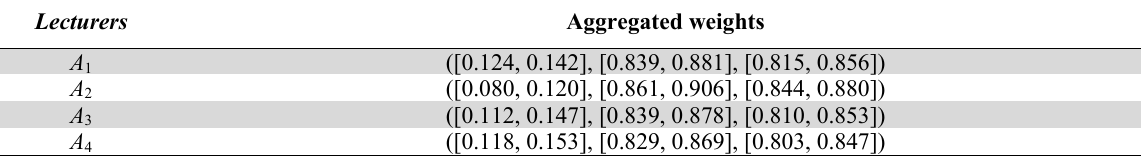
The final evaluation values of each lecturer Lecturers